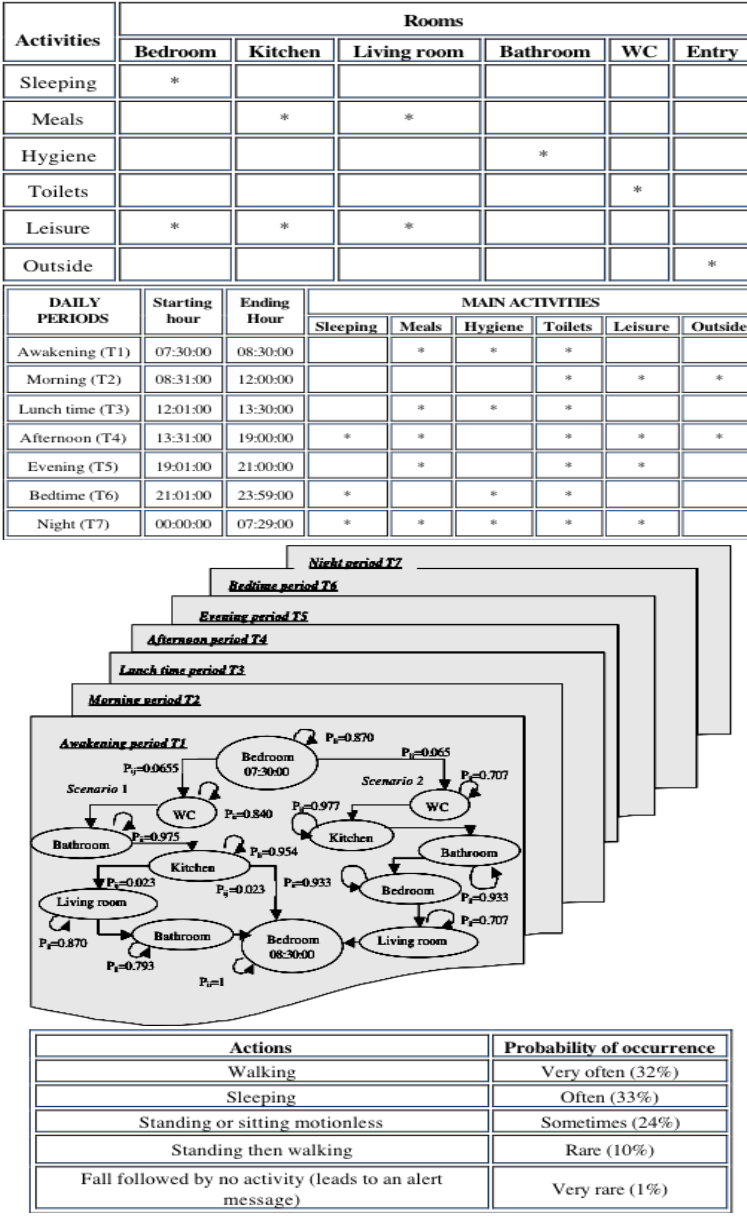
Figure 13. Top: activities in different rooms of the smart home and daily periods. Middle: scenarios of movements between successive different rooms. Bottom: probability of the occurrence of actions recorded through the number of minutes spent in each room in which the tasks corresponding to these actions are performed.